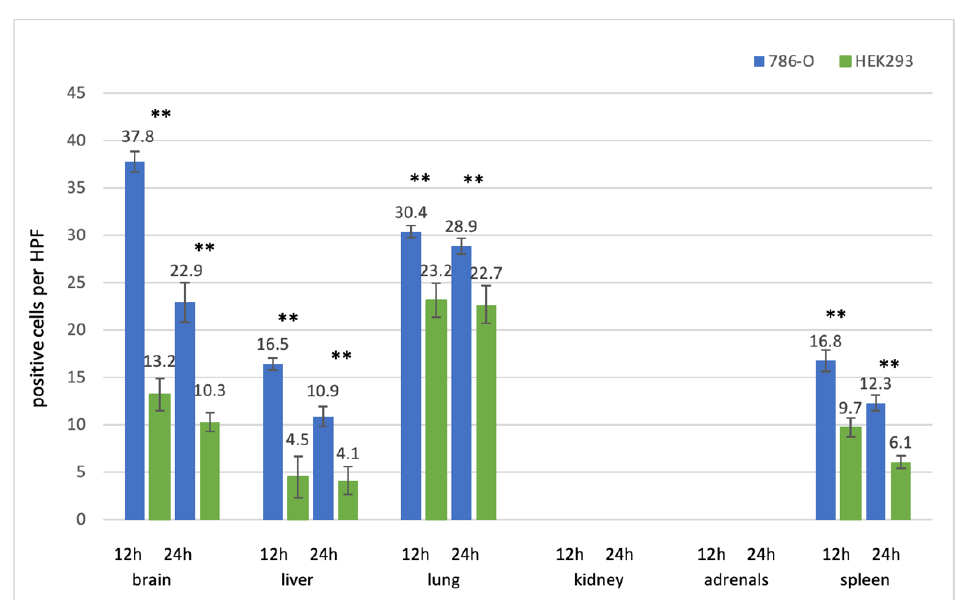
Figure 7. Uptake of fluorescence labeled 786-O and Hek293 EVs after intravenous injection. The number of EV-positive cells per high power field (HPF) is given for each organ and each time point. Columns for 786-O EVs are depicted in blue, those for Hek293 EVs in green. Medians +/− standard deviations are given. For each column, ten randomly chosen HPFs from two mice (5 per mouse) were analyzed. Significances were calculated using a 2way ANOVA test with Bonferroni correction. ** p < 0.01, ns = not